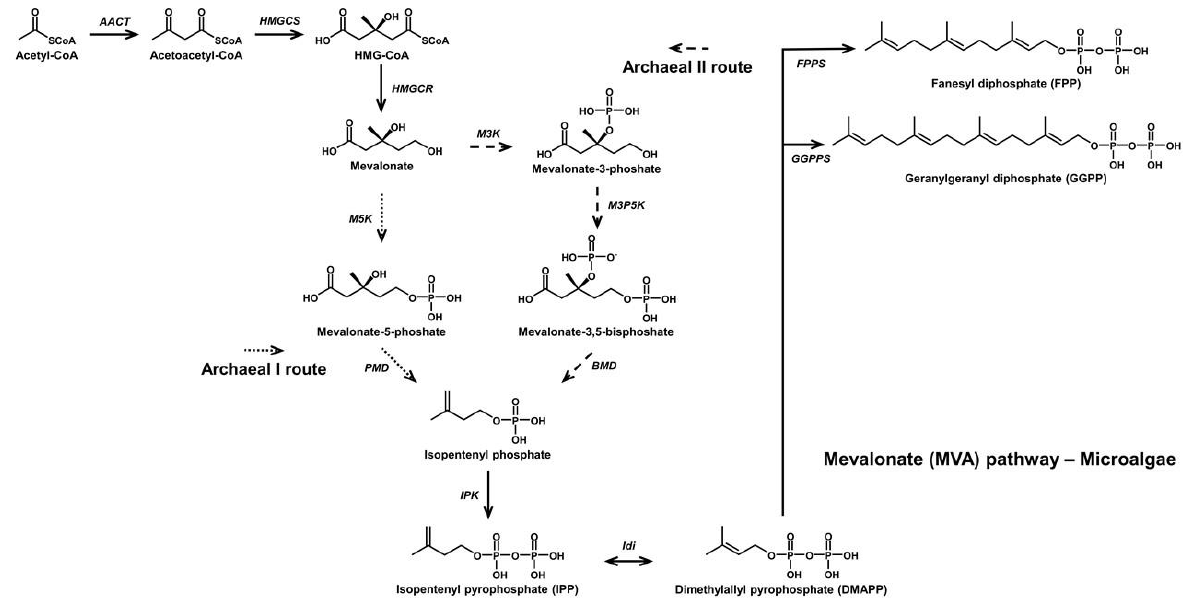
Figure 1. Mevalonate (MVA) pathway as taken by microalgae. AACT: Acetoacetyl-CoA thiolase. HMGCS: HMG-CoA synthase. HMGCR: HMG-CoA reductase. M3K: Mevalonate-3-kinase. M5K: